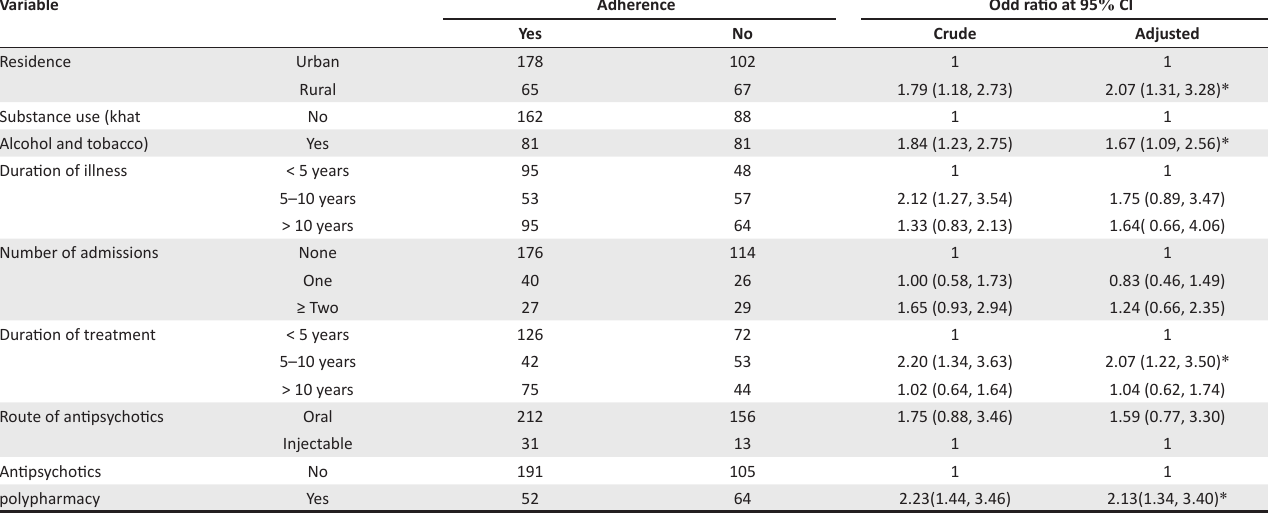
TABLE 3: Factors associated with antipsychotic polypharmacy among schizophrenia outpatients under follow-up at Amanuel Mental Specialized Hospital, Addis Ababa, Ethiopia, June 2014 ( n = 412).